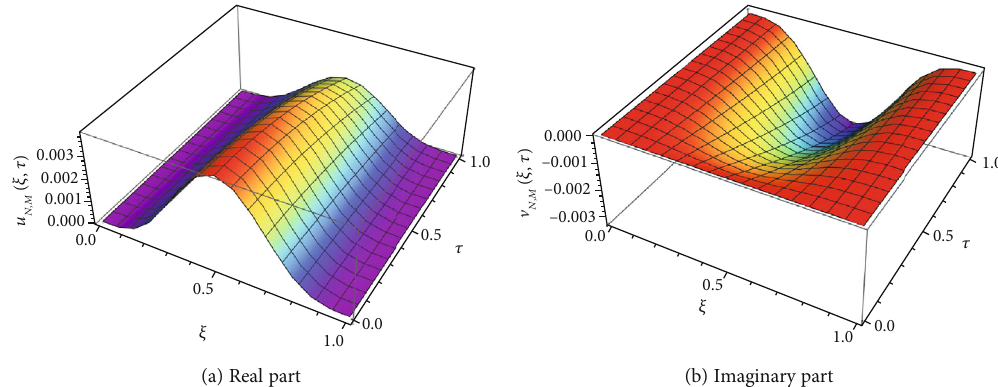
Figure 5: Space graphs of real and imaginary parts of the numerical solution of Equation (35).